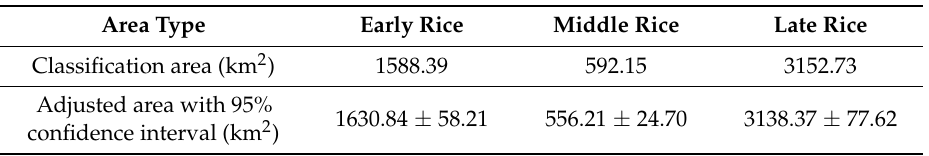
Figure 9. Distribution of extracted paddy rice: ( a ) early and middle rice; and ( b ) late rice. Table 3. Paddy rice area in different